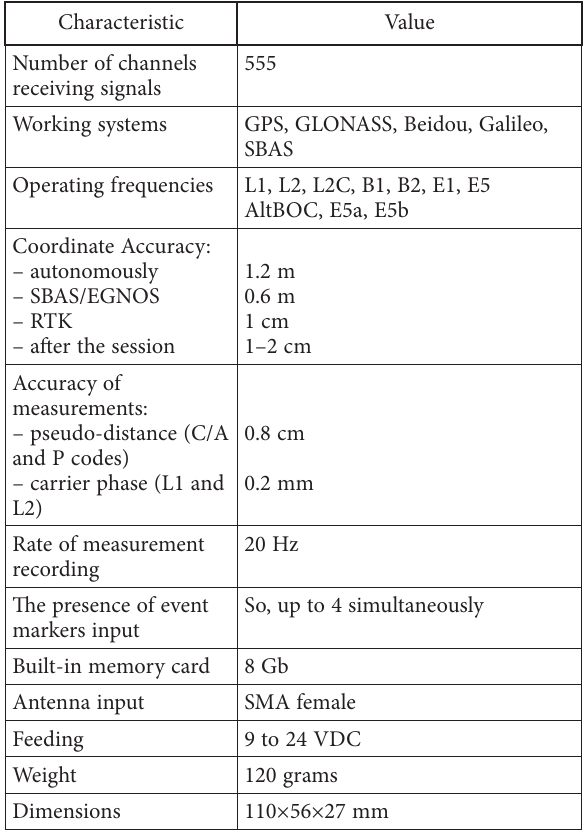
Table 2. Specifications of the